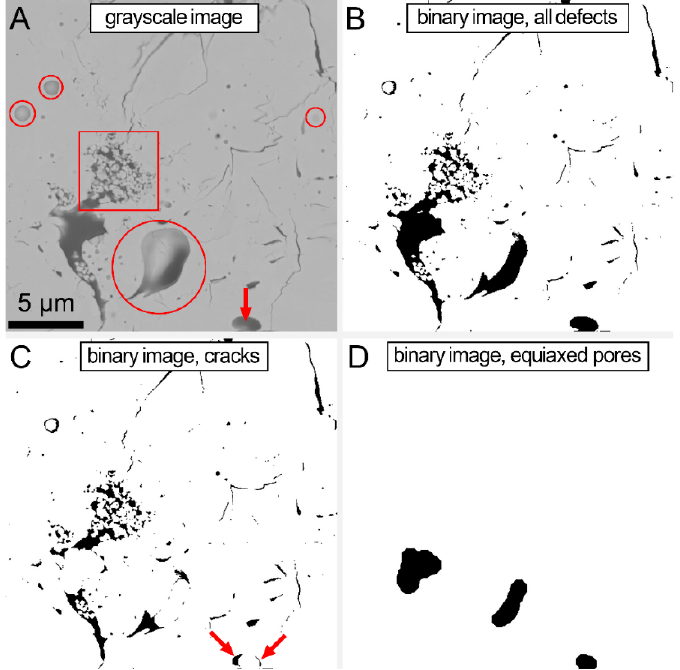
Figure 1. Images illustrating the procedures of conventional images analysis for SEM images of APS TBCs. ( A ) gray-scale BSE image, ( B ) binary image with all pores, ( C ) binary image with cracks and ( D ) binary image with equiaxed pores. The circles in ( A ) indicate pores whose gray values are close to the coating material; the squares indicate unmelted regions. The arrow in ( A ) indicates an equiaxed pore, some of which tend to be classified as cracks using an opening operation. The arrow in ( C ) indicate an equiaxed pore’s protrusions that were wrongly classified as cracks during opening operation.